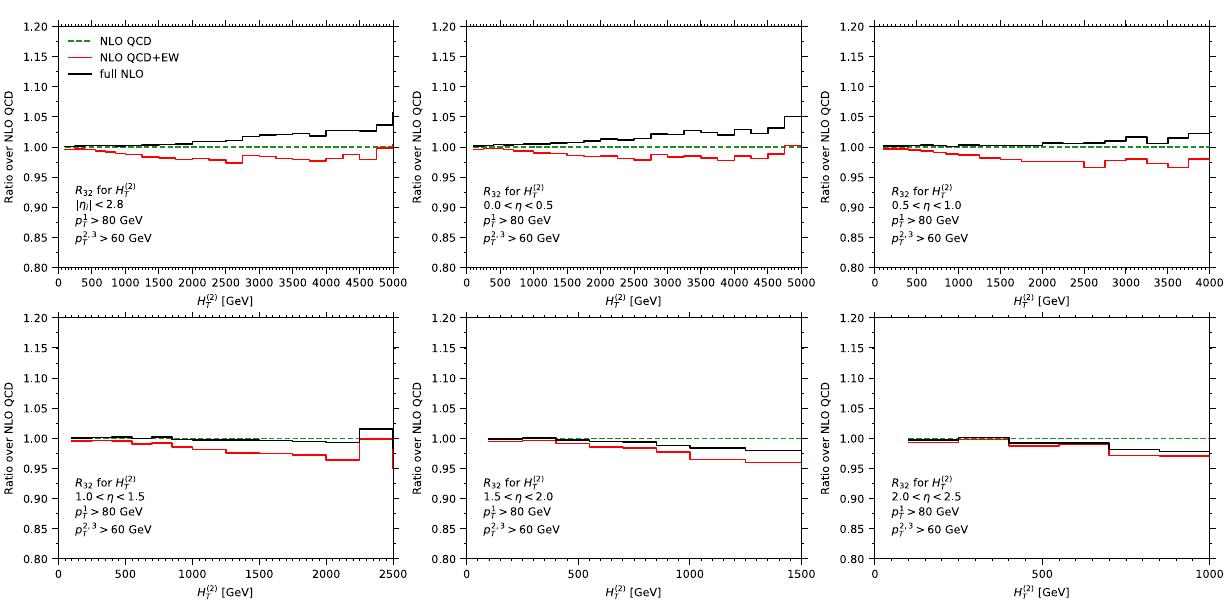
Fig. 9 The R 32 observable at NLO QCD + EW and full NLO differential in H ( 2 ) corresponding NLO QCD